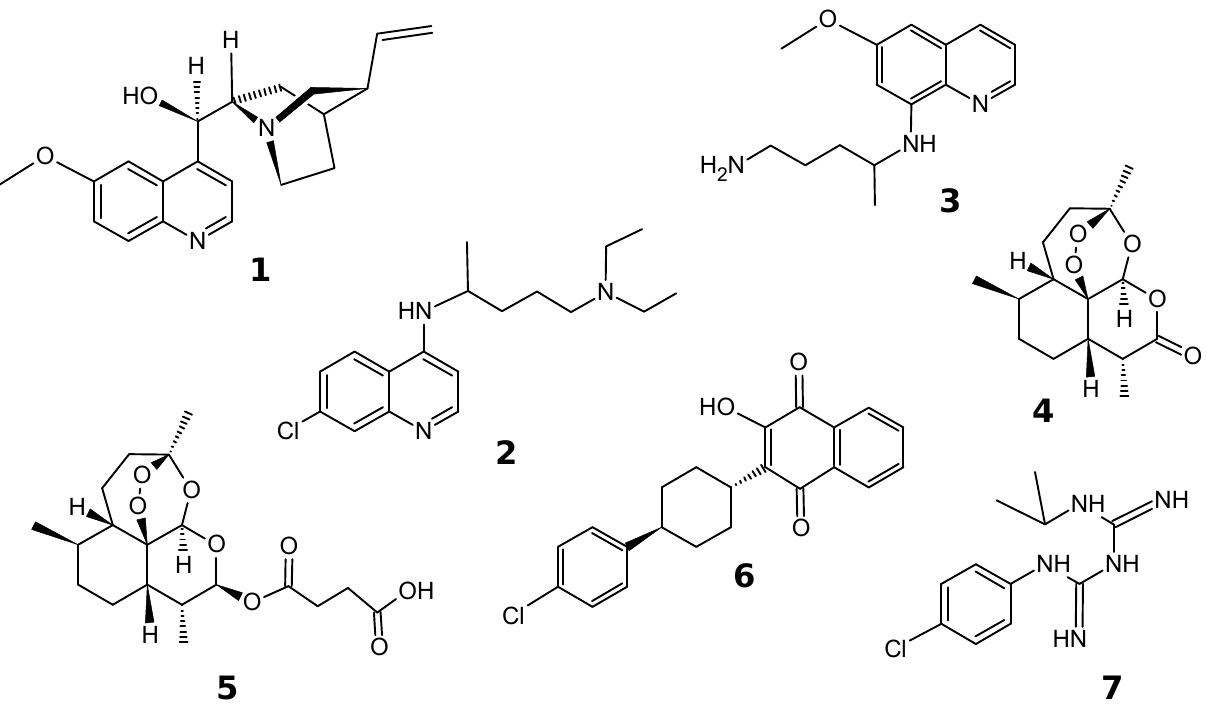
Figure 2. Some traditional antimalarial